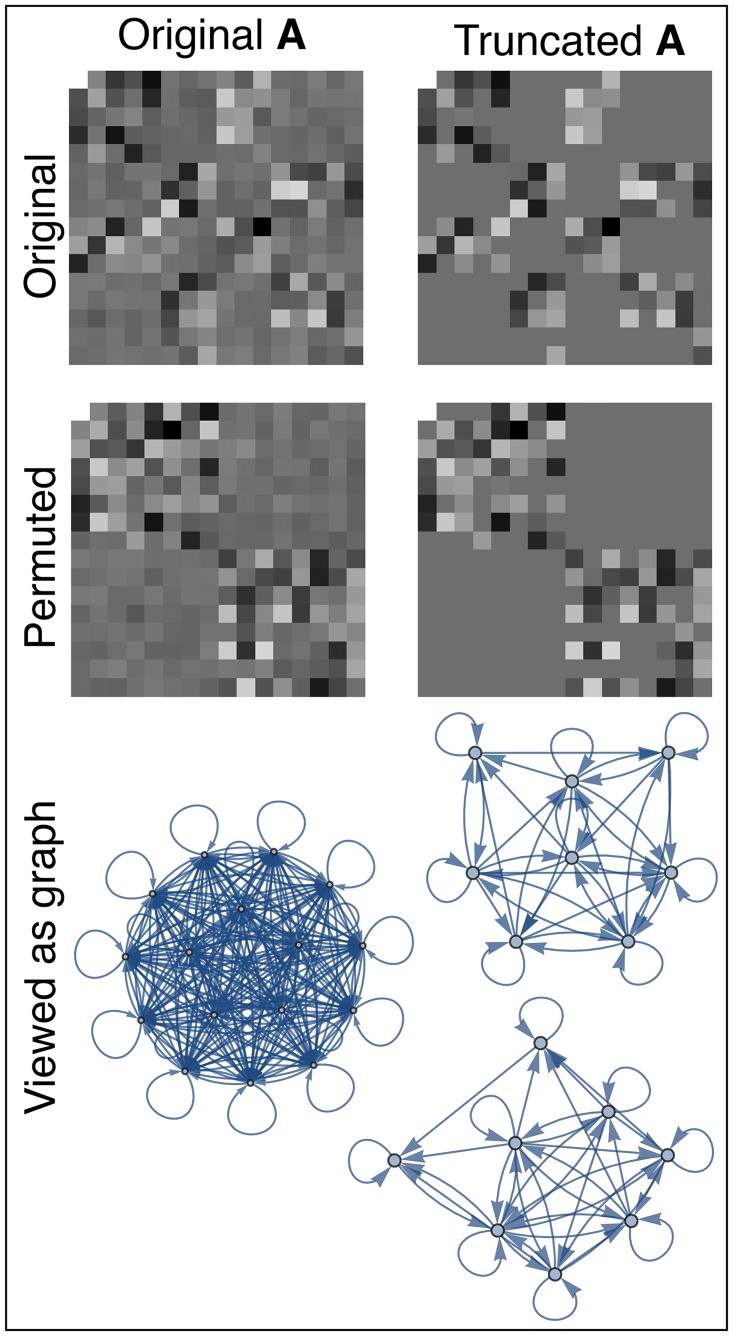
Illustration of our fast Φ-approximation for an n = 16 example.The structure of the A-matrix can be visualized either as a grid (top four examples) where each pixel color shows the value of the corresponding element Aij ranging from the smallest (black) to the largest (white), or as a graph (bottom examples) showing all non-zero matrix elements. Both of the matrices on the left correspond to the same graph below them, and both of the matrices on the right correspond to the same (disconnected) graph below them. Our method zeros all matrix elements |Aij| < ϵ below the threshold ϵ that makes the largest connected graph component involve merely half of the elements, which in the matrix picture means that there is a permutation of the elements (rows and columns) rendering the matrix block-diagonal (middle right). Whereas it would take exponentially long to try all matrix permutations, graph connectivity can be determined in polynomial time, thus enabling us to rapidly find a good approximation for the “cruelest cut” bipartition.